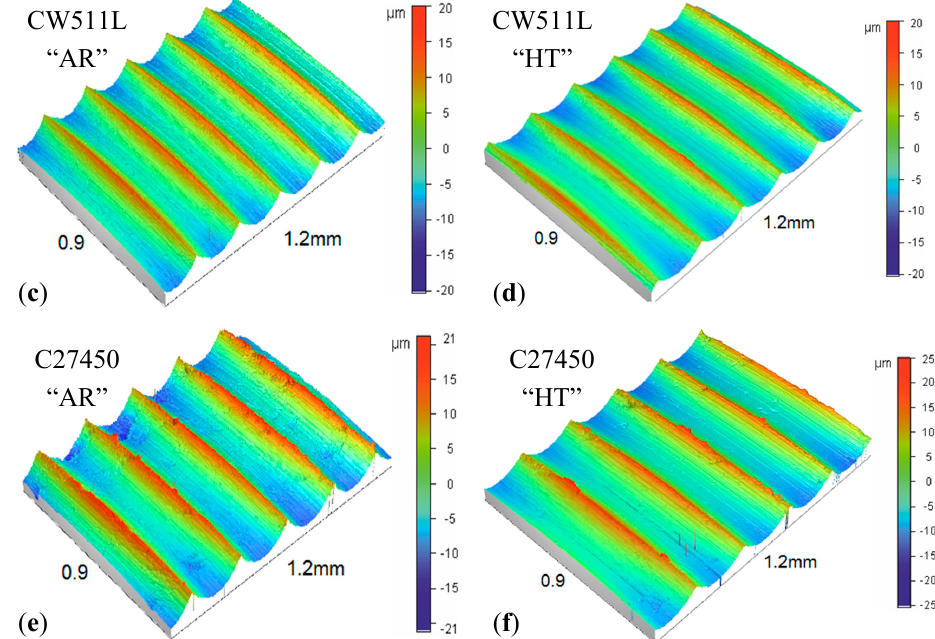
Figure 6. Surface topography derived from profilometric measurements: ( a ) CW510L_As received, ( b ) CW510L_Heat treated, ( c ) CW511L_As received, ( d ) CW511L_Heat treated, ( e ) C27450_As received, and ( f ) C27450_Heat treated. Table 8. Surface roughness results of lead-free brasses after selected heat treatment processes. Temp. (°C) Soaking Time